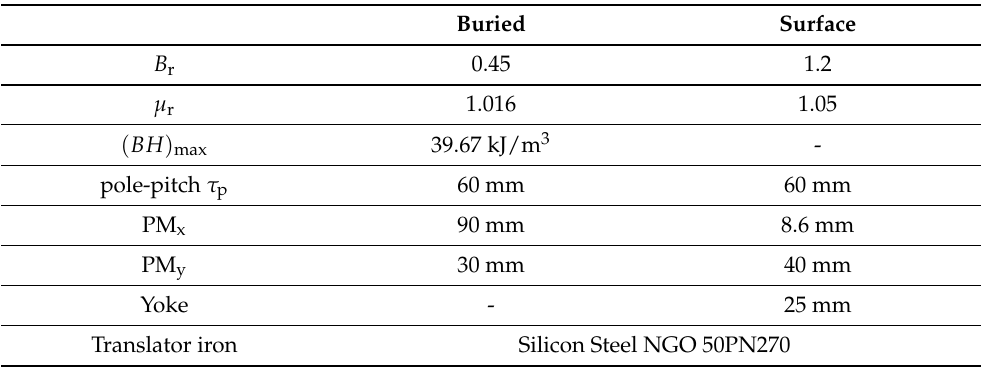
Figure 2. Illustrations for the buried topology. ( a ) shows the initial position with 50% stator overlap and the coordinate system. The translator moves in the negative y-direction in the simulations. The arrows indicate PMs of alternating direction, and the inclined lines indicate the domains for silicon steel. The winding patterns are shown for q = 1 and q = 6/5 in ( b ) and ( c ), respectively. Table 1. Translator parameters.